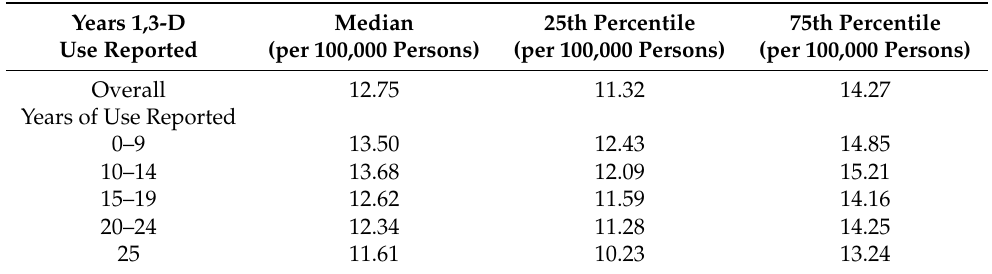
Table 2. Median and interquartile range of pancreatic cancer-related mortality rate by number of years of use data reported to the USGS,